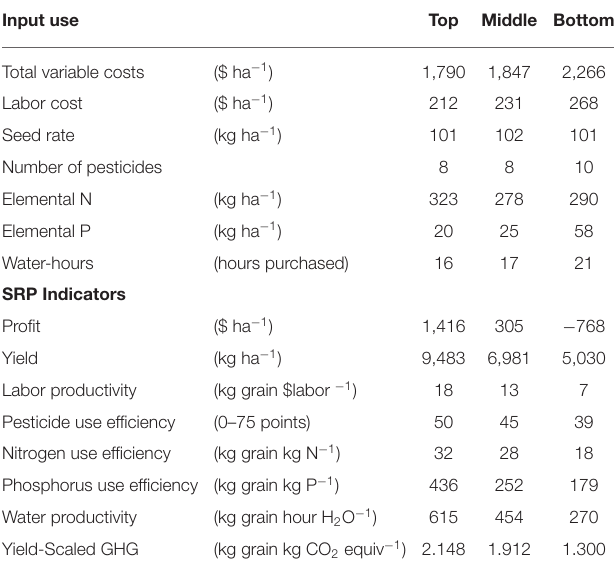
TABLE 3 | Production inputs and SRP indicators among three categories of farmers delineated by profit percentile in Ferreñafe, Peru for the 2019 season. Input use Top Middle